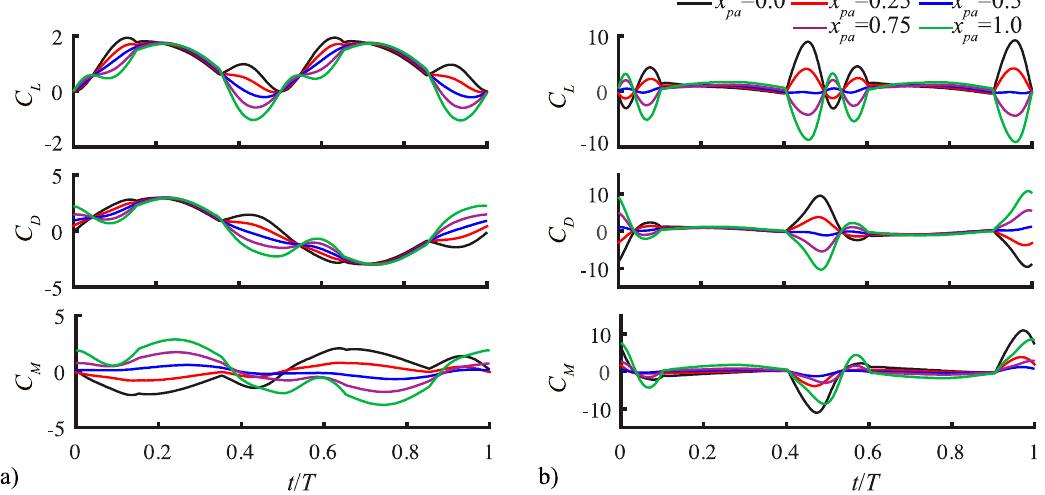
Figure 10. Plots of the NSe predicted lift, drag, and moment coefficient for cases with changing pitching axis, x pa = 0.0 (black), x pa = 0.25 (red), x pa = 0.5 (blue), x pa = 0.75 (purple), and ∆ τ r = 0.5 (green) ( a ) cases with A = 30 ◦ and ∆ τ r = 0.3 ( b ) cases with A = 60 ◦ and ∆ τ r = 0.2.